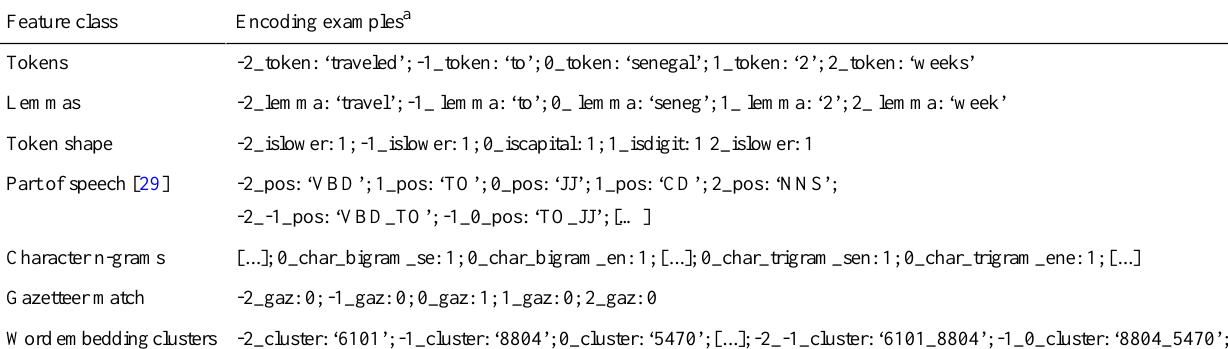
Table 1. Feature encoding examples for the token “Senegal” in Figure